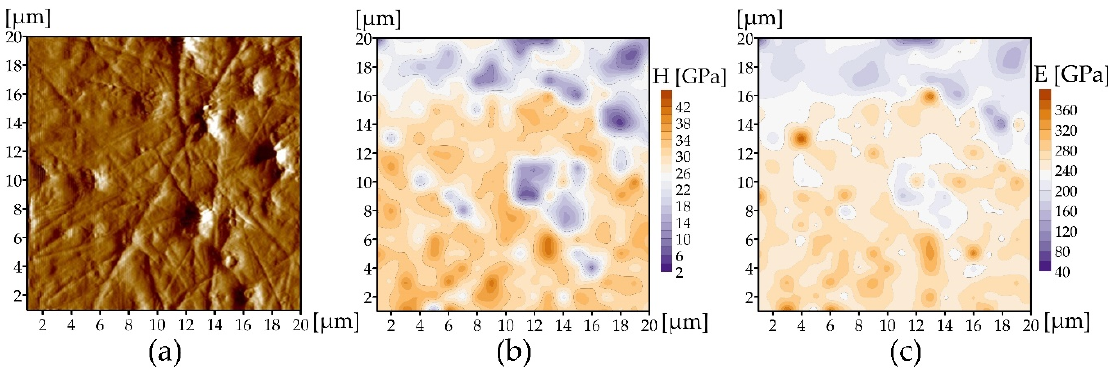
Figure 8. AlCrN coating deposited at p N2 = 3 Pa, Ic = 80 A: ( a ) surface morphology after polishing, ( b ) microhardness map, ( c ) Young’s modulus map. Coating area 20 × 20 µ m 2 .